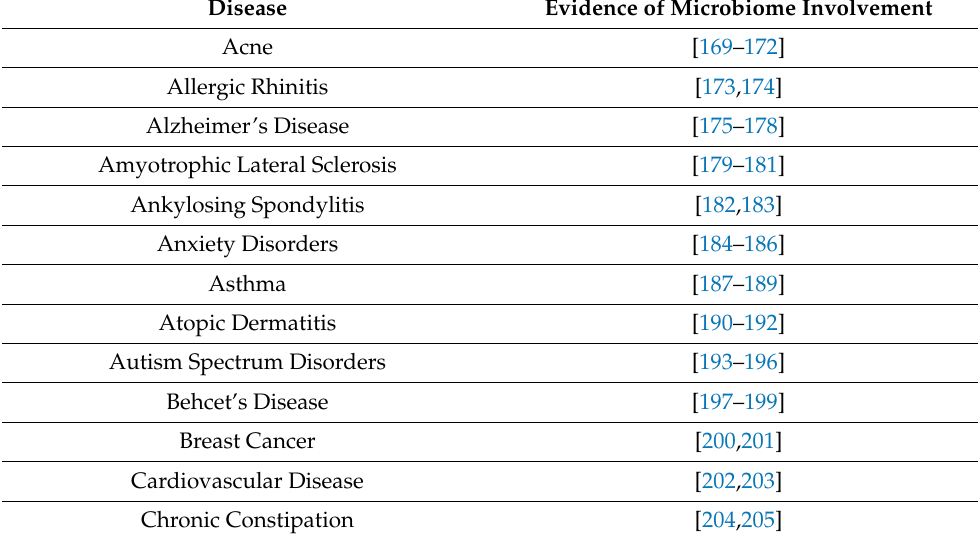
Table 2. Diseases that can exploit the human microbiome and microbiota metabolites as diagnostic